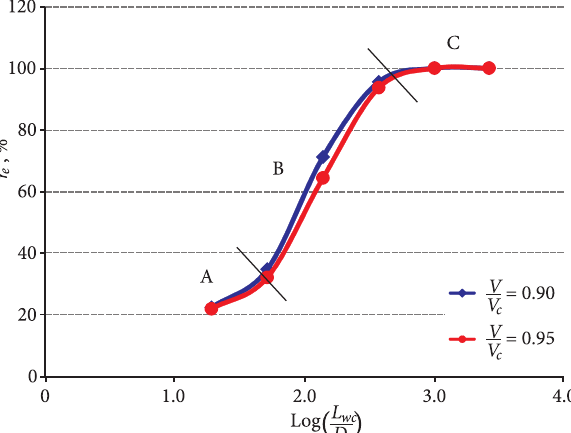
Fig. 9. The changes in the reduction percentage of scour depth in two-sided collars with varying